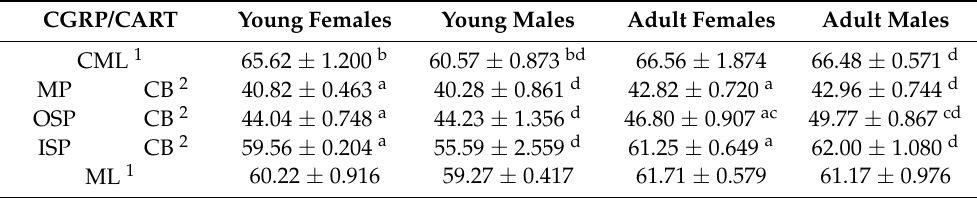
Table 4. The co-localization of CGRP with cocaine- and amphetamine-related peptide (CART) in the enteric nervous structures of the porcine descending colon under physiological conditions in young (10-week old) females and males and adult (6–8 months old) females and males. CGRP/CART Young